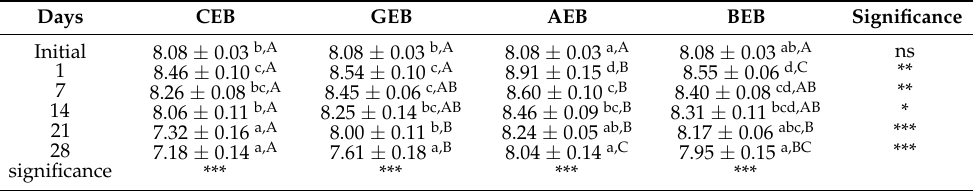
Table 5. Viability (log CFU g − 1 ) of L. plantarum 2035 during storage of the beverages. Days CEB GEB AEB